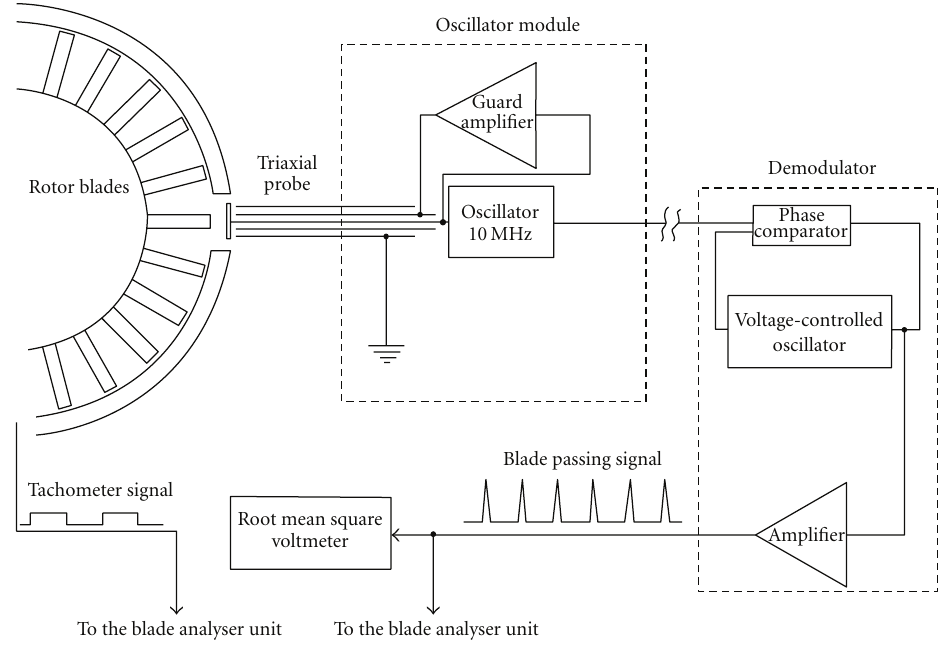
Figure 2: FM type capacitance tip clearance measurement system, schematic block